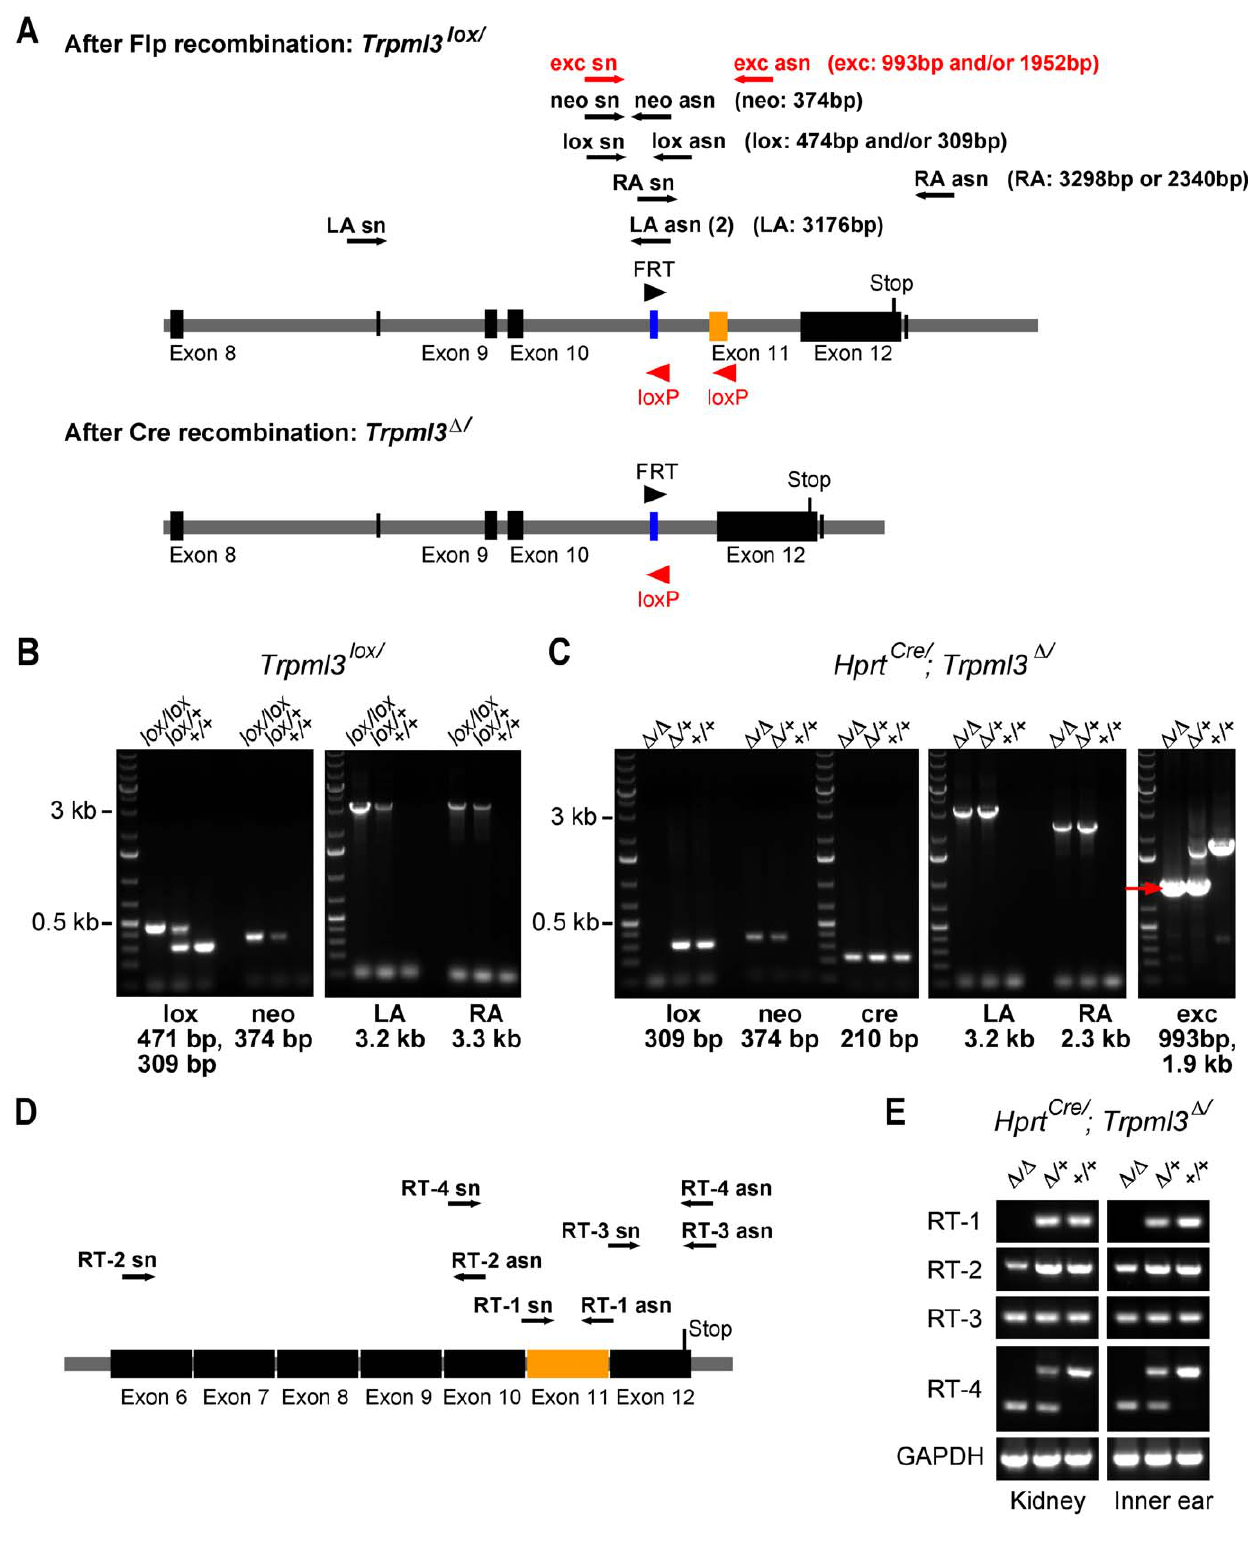
Figure 2. Genotyping analysis. A, Schematic drawing of the Trpml3 targeted allele before ( Trpml3 lox/ ) and after Cre recombination ( Trpml3 D / ). The positions of sense (sn) and antisense (asn) oligonucleotides are indicated with arrows. The names of PCR products and the corresponding lengths are parenthesized. B, PCR amplification products of Trpml3 locus of homozygous (lox/lox), heterozygous (lox/ + ), and wild-type ( + / + ) Trpml3 lox/ mice are shown: lox: 309 bp and/or 471 bp, neo: 374 bp, and left arm (LA): 3176 bp and right arm (RA): 3298 bp. C, Genotyping after Cre recombination of representative Hprt Cre/ ;Trpml3 D / mice. All mice are heterozygous for cre (210 bp). The same sets of oligonucleotides were used as in (B), however lox- PCR only displayed the wild-type 309 bp PCR fragment, since the lox asn-oligonucleotides cannot hybridize after the targeted exon 11 was excised; and RA: 2340 bp, since exon 11 was excised by Cre. The last panel on the right shows the shortened fragment (indicated with a red arrow): 1952 bp